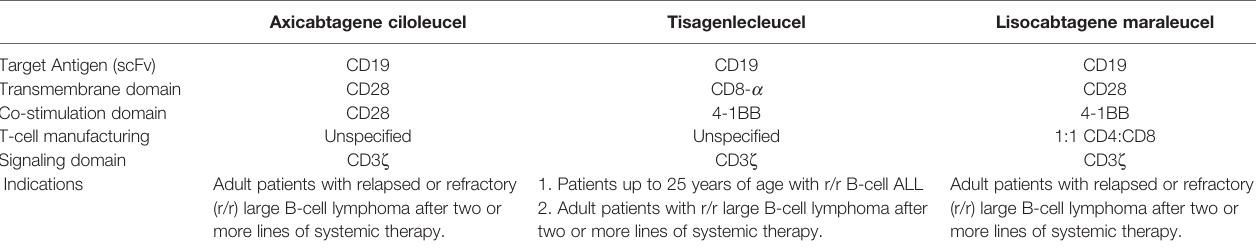
TABLE 1 | CAR T-cell product composition